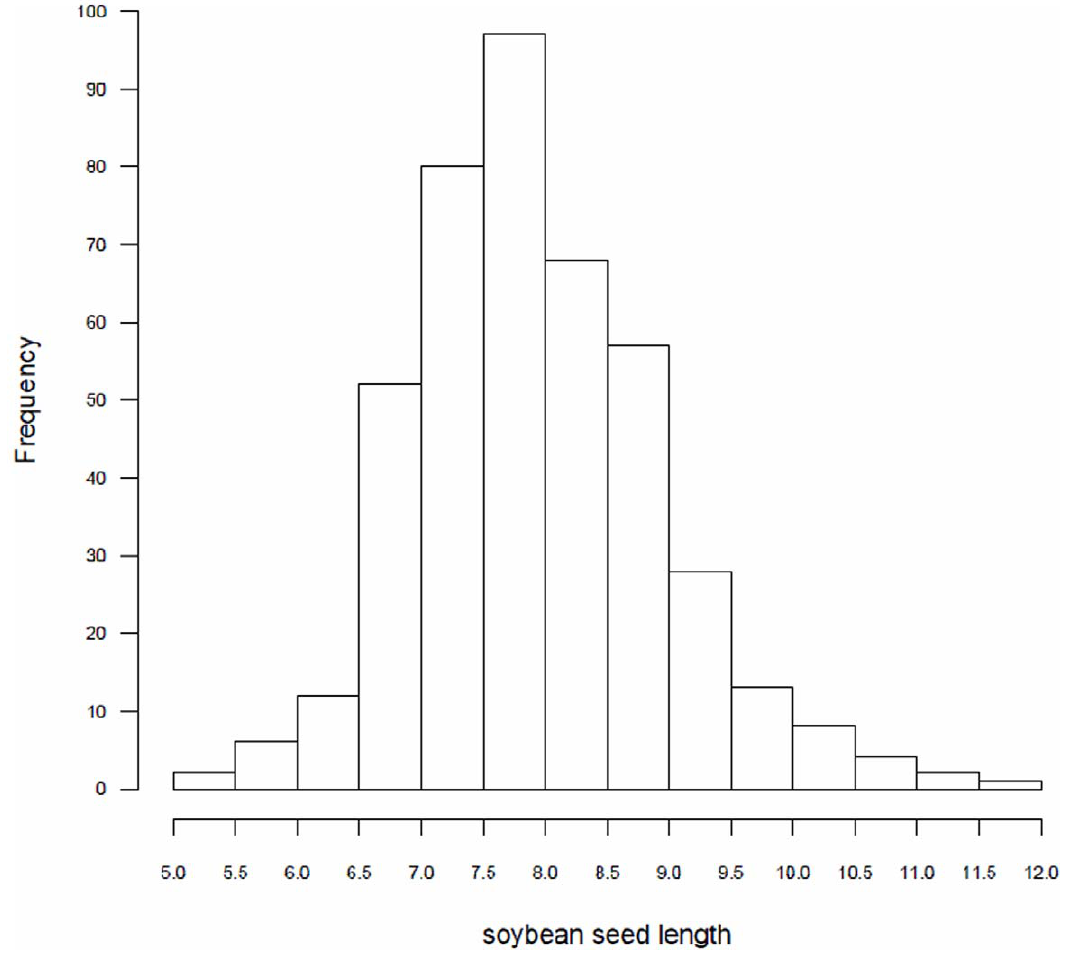
Figure 1. Frequency distribution for soybean seed length.